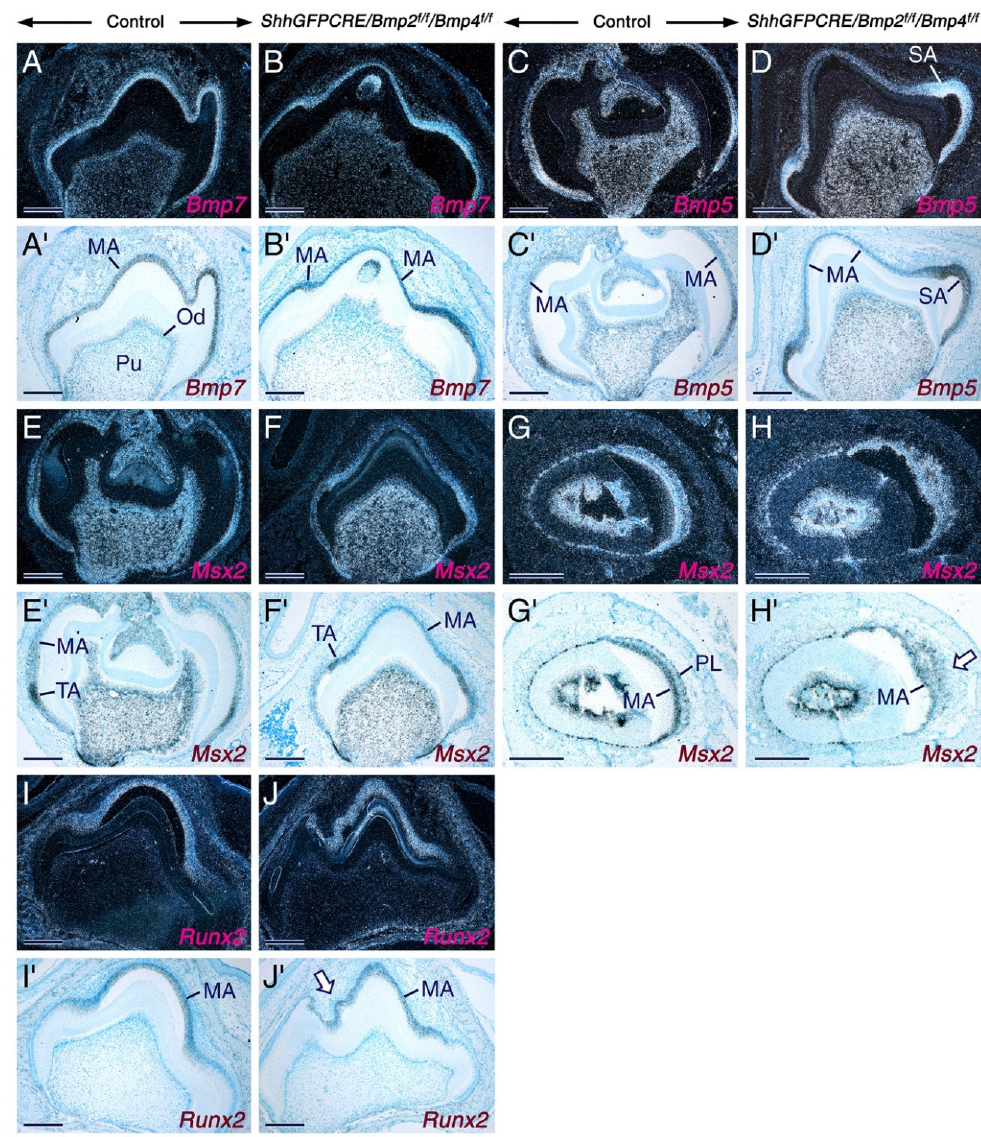
Figure 5. Normal expression patterns of Bmp5 , Bmp7 , Msx2, and Runx2 upon combined loss of BMP2 and BMP4 signaling in the dental epithelium. ( A – J’ ) Representative in situ hybridization data in sections across molars ( A – F’ , I–J’ ) and incisors ( G – H’ ) from 12 days post-partum control and ShhGFPCRE/Bmp2 f/f /Bmp4 f/f mice showing the expression patterns of Bmp7 ( A – B’ ), Bmp5 ( C – D’ ), Msx2 ( E – H’ ), and Runx2 ( I – J’ ). The hybridization signals appear as shiny or black dots in dark-field ( A – J ) and bright-field ( A’ – J’ ) images, respectively. In the mutant teeth, the intensity of Bmp5 , Bmp7 , Msx2, and Runx2 hybridization signals in maturation-stage ameloblasts, including in cells that have migrated away from the ameloblast layer (arrow in ( H’ )) and in cells within regions of disrupted ameloblast layer (arrow in ( J’ )), is indistinguishable from that in maturation-stage ameloblasts of control teeth. MA, maturation-stage ameloblasts; Od, odontoblasts; Pl, papillary layer; SA, late secretory ameloblasts; TA, transition-stage ameloblasts; Pu, dental pulp tissue. Scale bars: 200 µm ( A – J’ ).